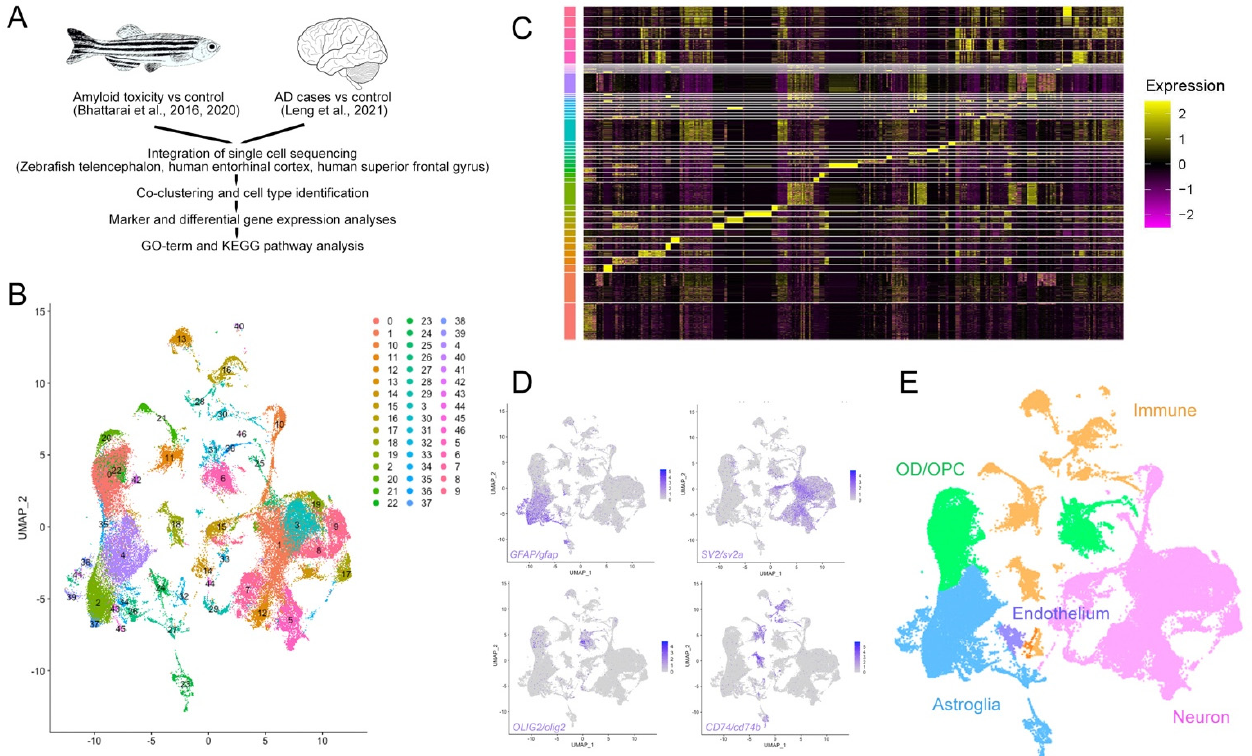
Figure 3. Integration of single cell transcriptomics data from zebrafish and human brains in AD. ( A ) Schematic work pipeline for integration of open-access datasets from [29,37,40–49]. ( B ) tSNE plot that co-localizes and clusters human and zebrafish cells. ( C ) Heat map of the marker genes of the identified clusters. ( D ) Exemplary gene expression for cell clusters: GFAP for astroglia, SV2 for neurons, OLIG2 for oligodendrocytes, and CD74 for immune cells. ( E ) Colored cell type identification tSNE for human and zebrafish composite single cell clustering. See Figures S1 and S2 and Data S1.